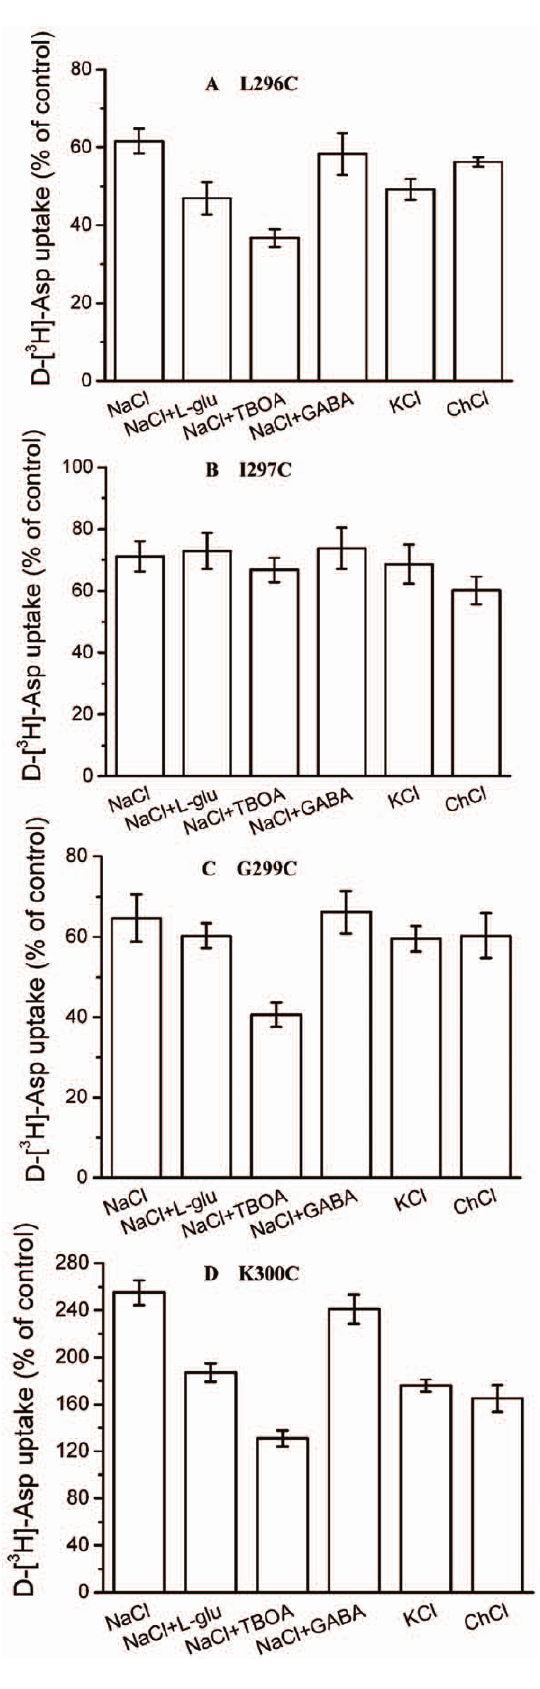
Figure 5. Effect of the composition of the external medium on the inhibition of single cysteine mutants by MTSET. HeLa cells expressing the single cysteine mutants L296C ( A ), I297C ( B ), G299C ( C ) or K300C ( D ), were preincubated for 5 min in the presence or absence of 0.2 ( A ), 1.0 ( B ), 0.6 ( C ) or 0.01 ( D ) mM MTSET. The indicated preincubation solutions contained NaCl, NaCl + 1mM L-glutamate, NaCl + 20 m M TBOA, NaCl + 1mM GABA, KCl, choline chloride. Subsequently the cells were washed and D-[ 3 H]-aspartate transport was measured as described under ‘‘Materials and methods’’. Values are given as a percentage of control (preincubation without MTSET) and represent the mean 6 S.E. of at least three different experiments done in